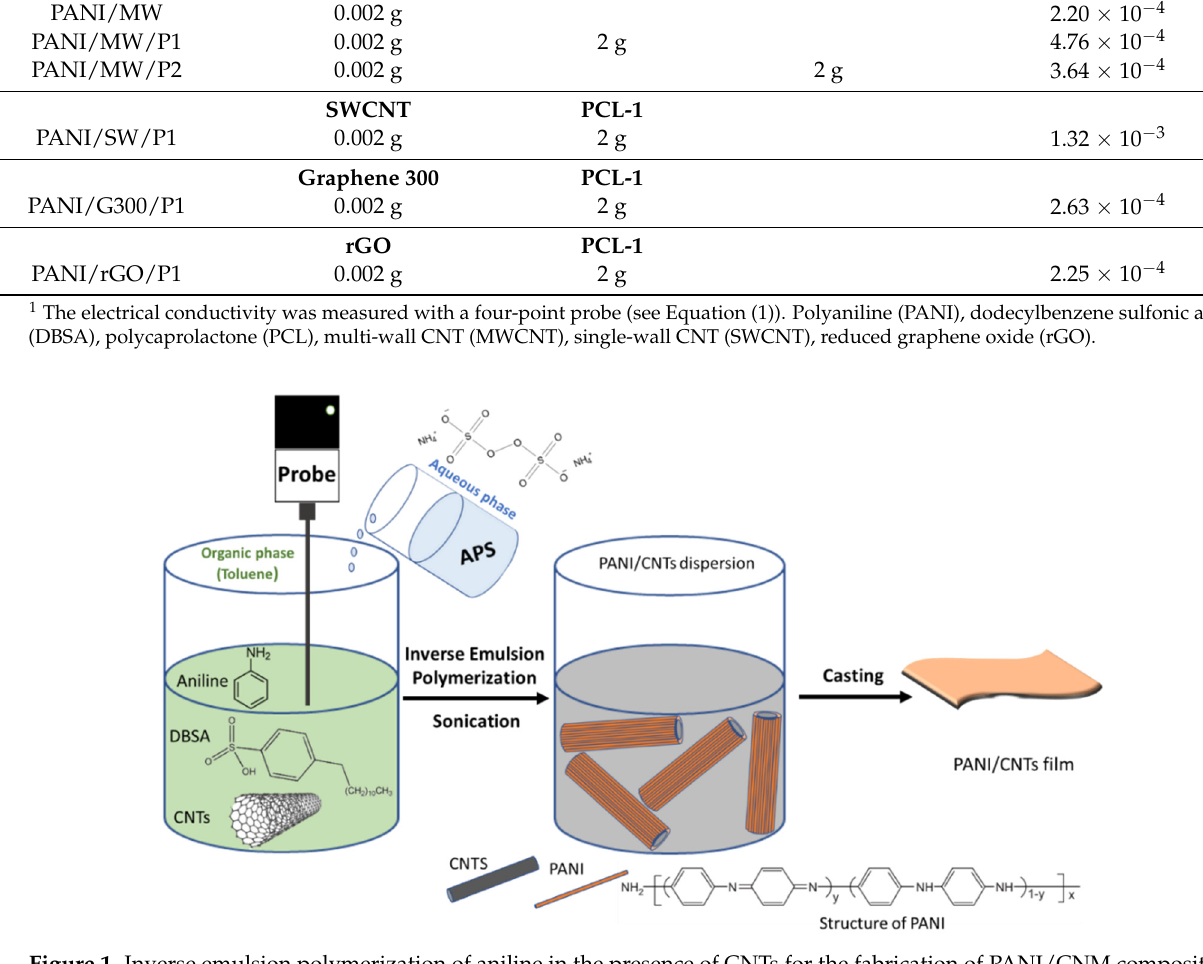
Table 1. Preparation of different nanocomposites and their electrical conductivity. Samples